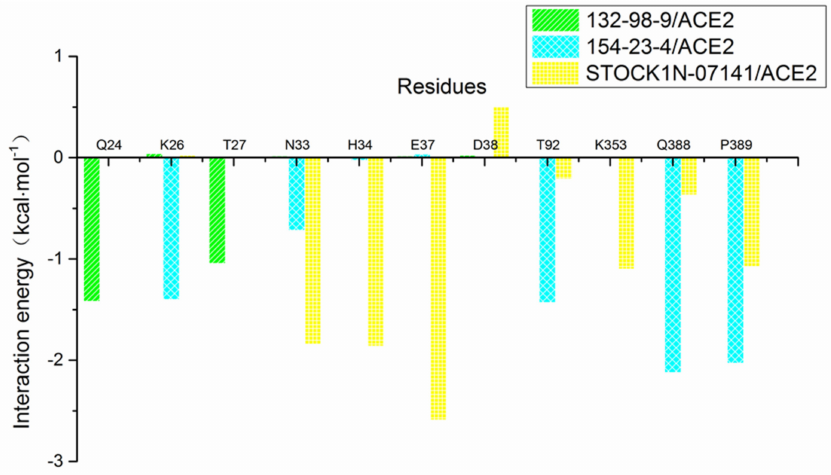
Figure 8. Contributions of partial residues calculated by decomposing the binding